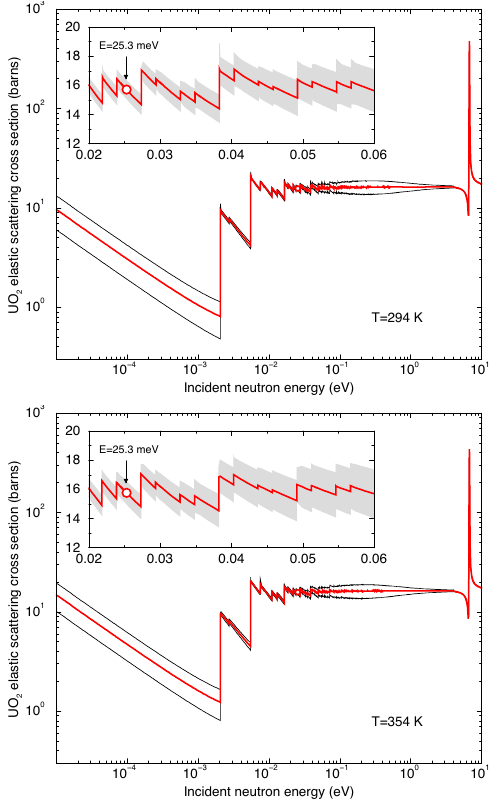
Fig. 10. Elastic scattering cross sections of UO 2 calculated at 294 and 354 K with the JEFF-4T1 evaluations. The solid black lines and the grey zones represent the uncertainties.